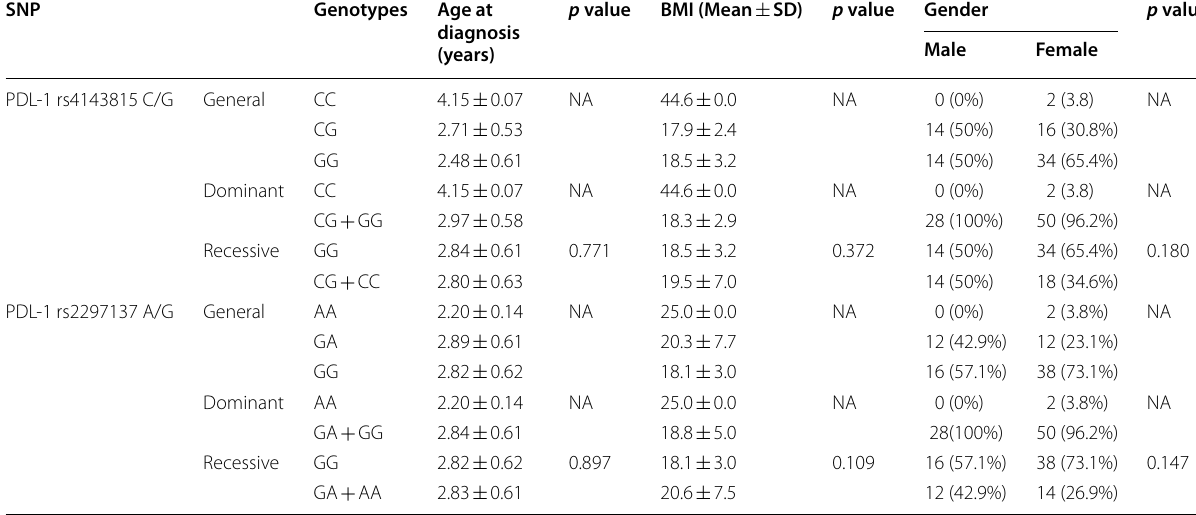
BMI, body mass index; NA, non-applicable; SNP, single nucleotide polymorphism; SD, standard deviation; PDL-1, programmed death-ligand 1 * p value is non-applicable due to the small number of cases